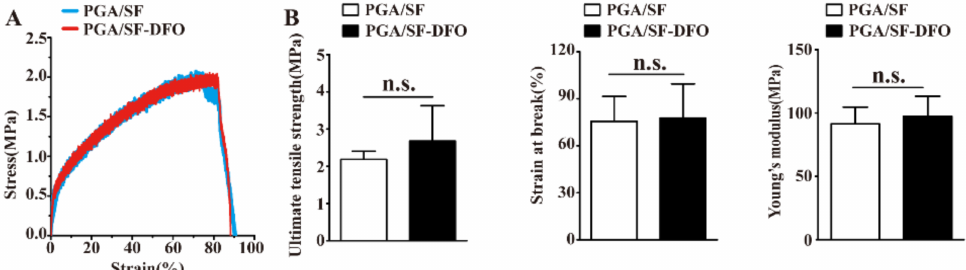
Figure 2. Mechanical properties of different scaffolds. ( A ) The stress–strain curves. ( B ) Ultimate tensile strength, strain at break, and Young’s modulus. n.s. represents no significant